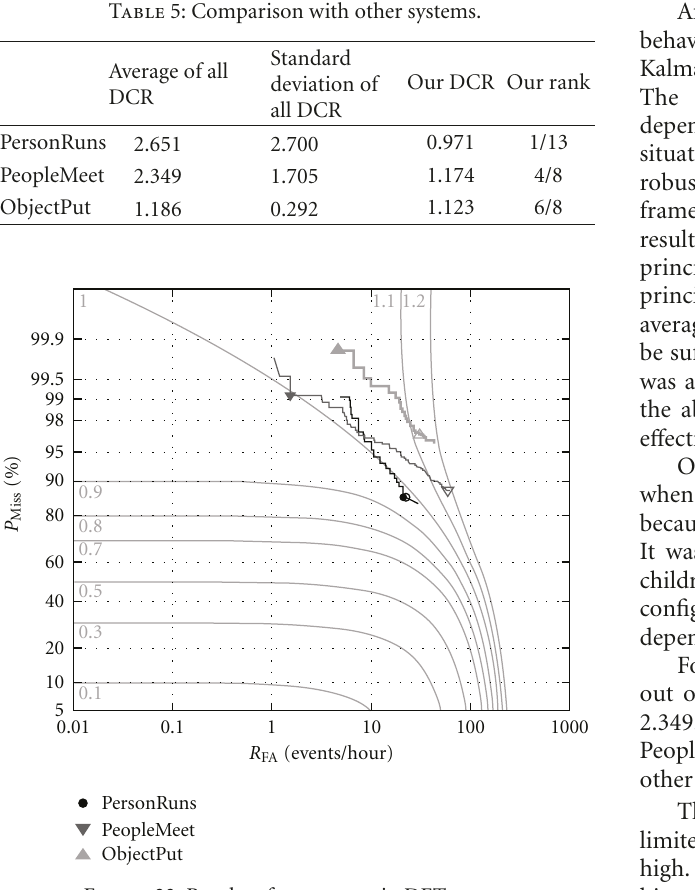
Figure 22: Results of our system in DET